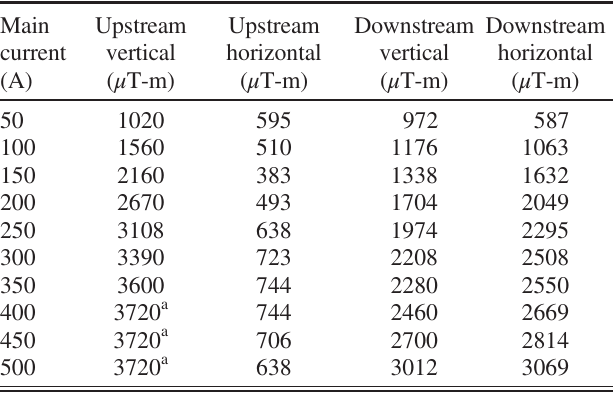
TABLE VI. Vertical and horizontal field correction necessary to minimize the field integrals.